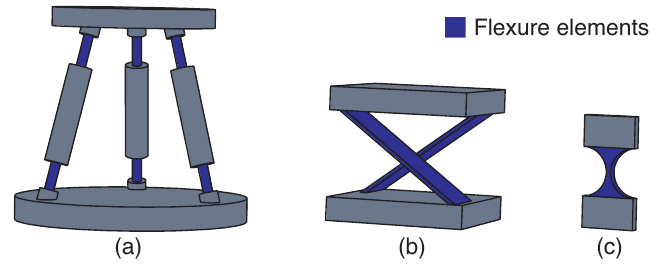
Figure 1. Compliant systems: ( a ) compliant mechanism, ( b ) compliant joint, and ( c )